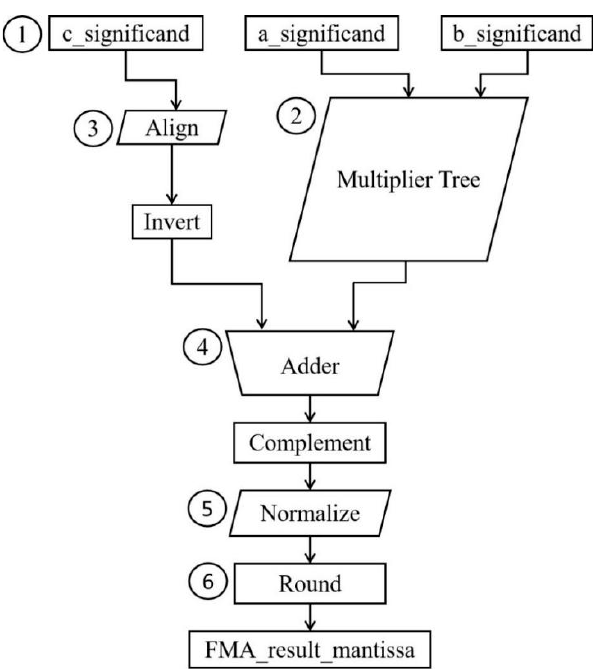
Figure 3. The algorithm diagram of FMA operator.